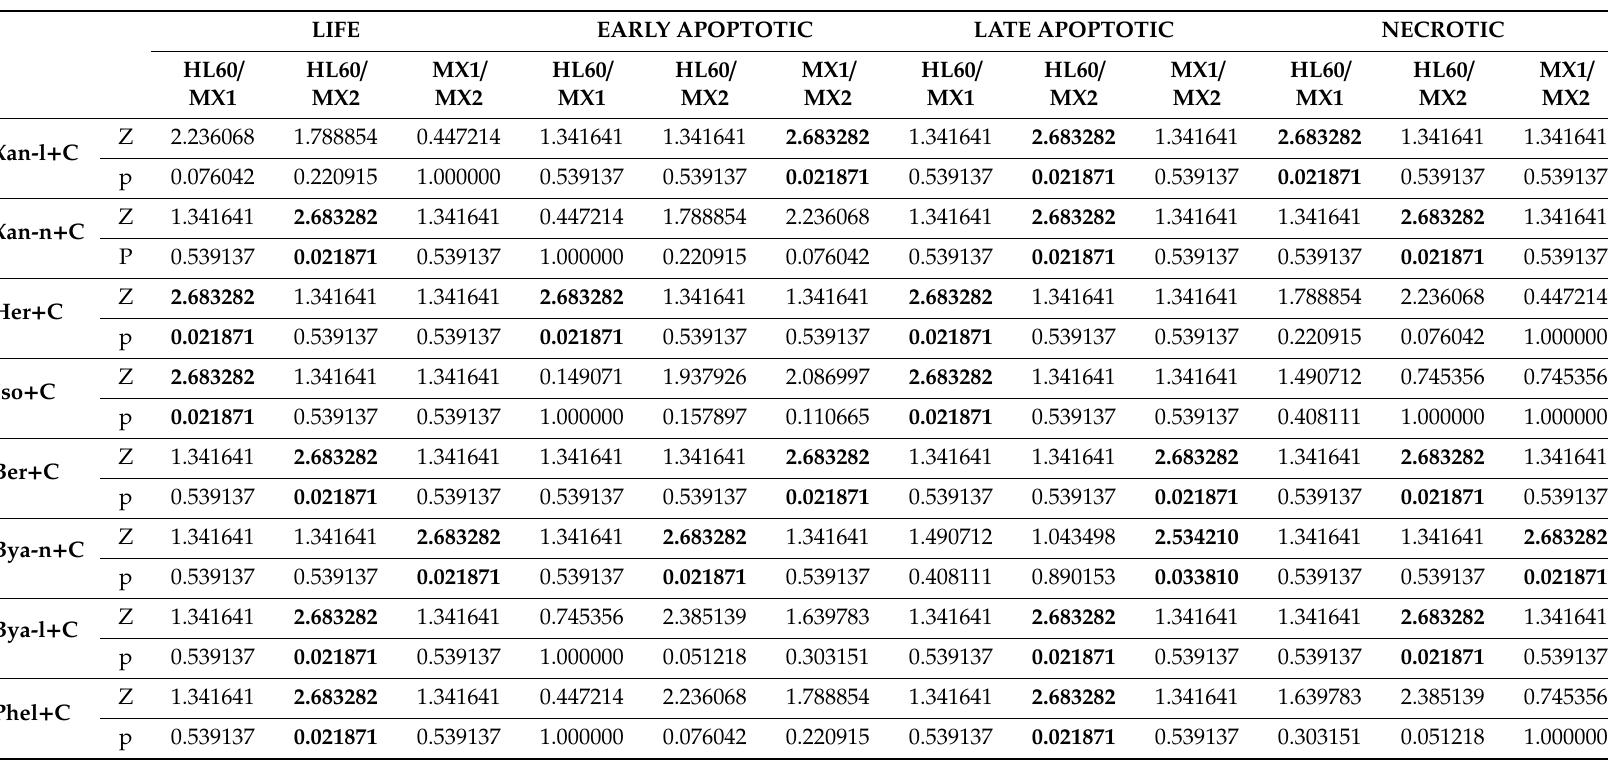
Table 2. Statistically significant di ff erences between the lines exposed to the tested furanocoumarin with the presence of mitoxantrone ( + C). Results of Kruskal–Wallis test: “Z” values for multiple comparisons, “ p ” values for multiple comparisons. The level of significance was set at p <